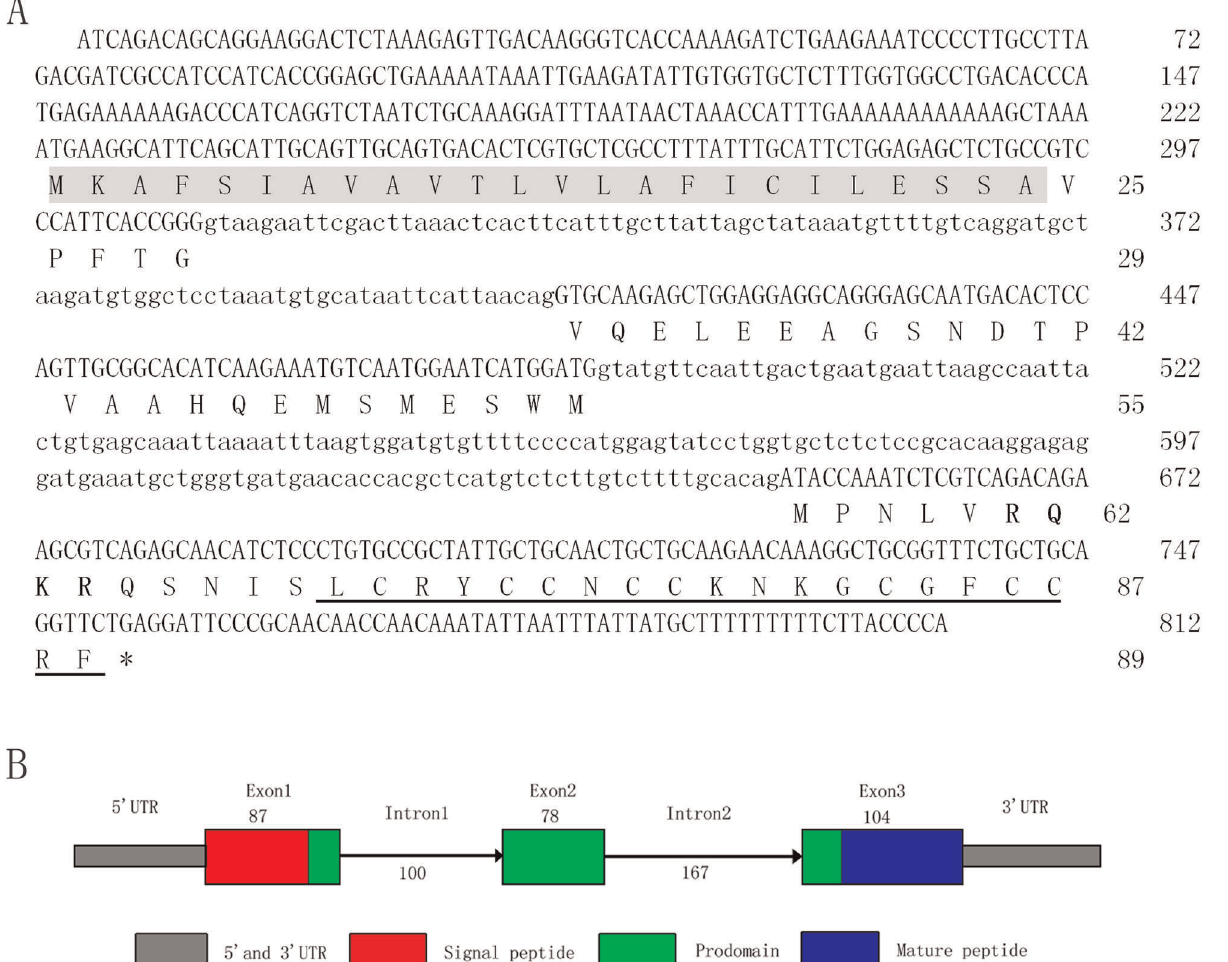
Figure 1. Genomic sequence (A) and schematic illustration (B) of miiuy croaker hepcidin gene. Exons are in uppercase and introns are in lowercase. An asterisk indicates the stop codon. The signal peptide and mature peptide is showed as gray background and underlined, respectively.